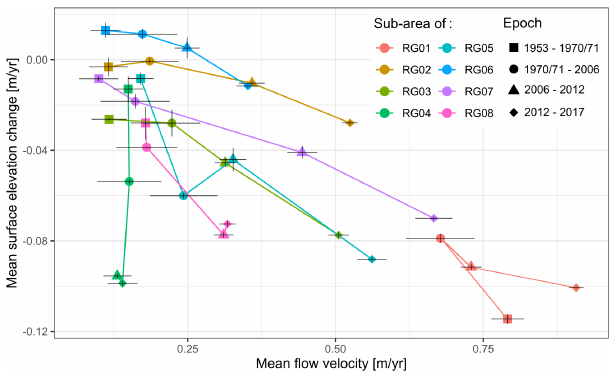
Figure 11. Mean flow velocity plotted against mean surface eleva- tion change for subareas of the investigated rock glaciers (indicated in Fig. 10) and the four epochs between 1953 and 2017. The black crosses represent the uncertainty in the mean flow velocity and the mean surface elevation change,